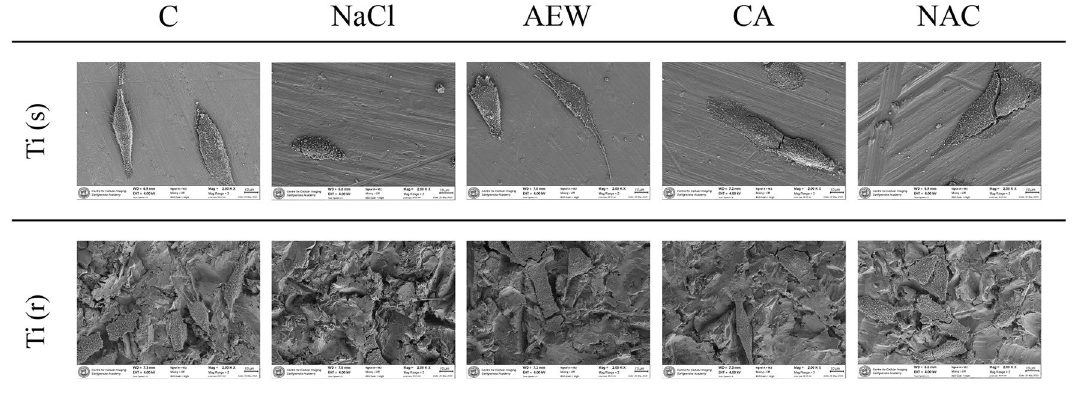
Figure 4. Representative SEM images of the two different titanium surfaces following application of four different decontamination methods and control discs.